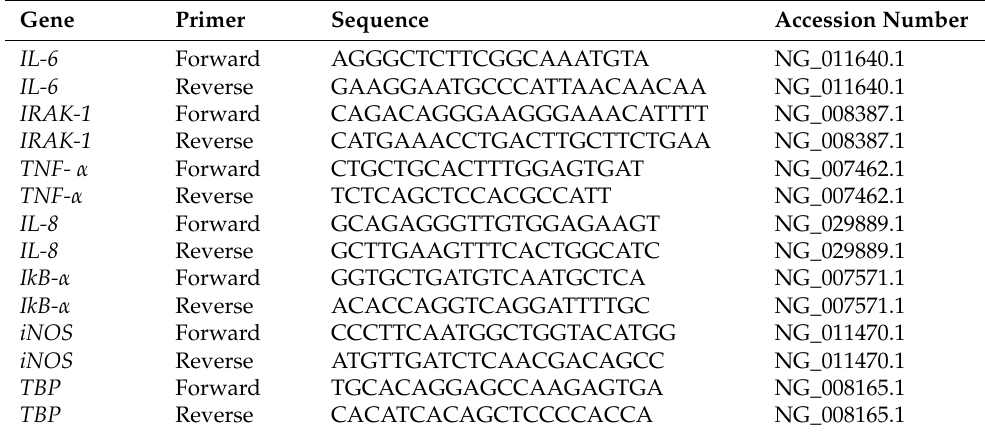
Table 1. Primer sequences for real-time